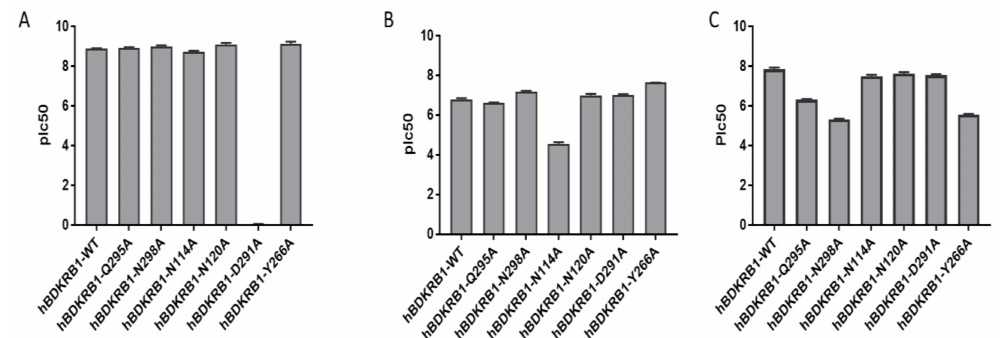
Figure 4. E ff ect of single point mutations on compound activity. [Leu 8 ]-Lys-desArg 9 -BK activity is a ff ected only by D291A, which is known to be a key residue for orthosteric cavity ( A ). DFL20656 and Merck compounds are a ff ected by mutations inside the minor pocket but with a di ff erent pattern, to note that both are una ff ected by the D291A mutation. DFL20656 presents a single key interaction with the N114A ( B ). The Merck compound 14 is not a ff ected by N114A mutation by engaging the minor pocket with a di ff erent pattern of interactions, in fact its activity is reduced by N298A, Y266A and Q295A ( C ). The data represent the mean of six experimental replicates. All data were presented as the mean ± SEM. Bonferroni-Dunn post hoc test was used. p < 0.05 was considered representative of